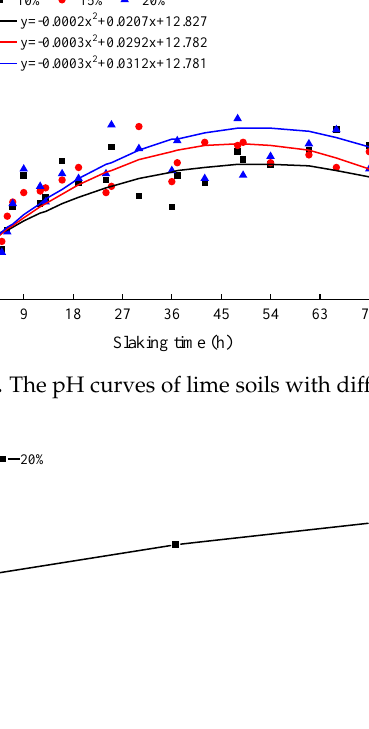
Figure 3. Particle gradation of specimens with different slaking times, lime contents and moisture